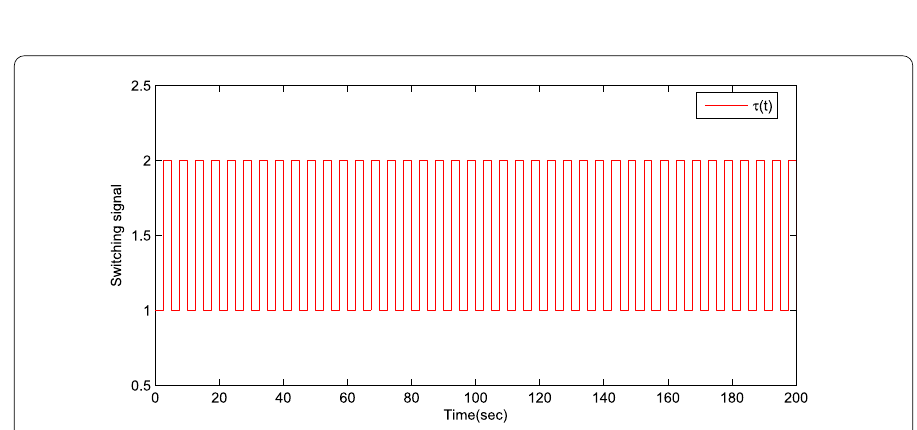
Figure 4 Responses of the control input signal of Example 1